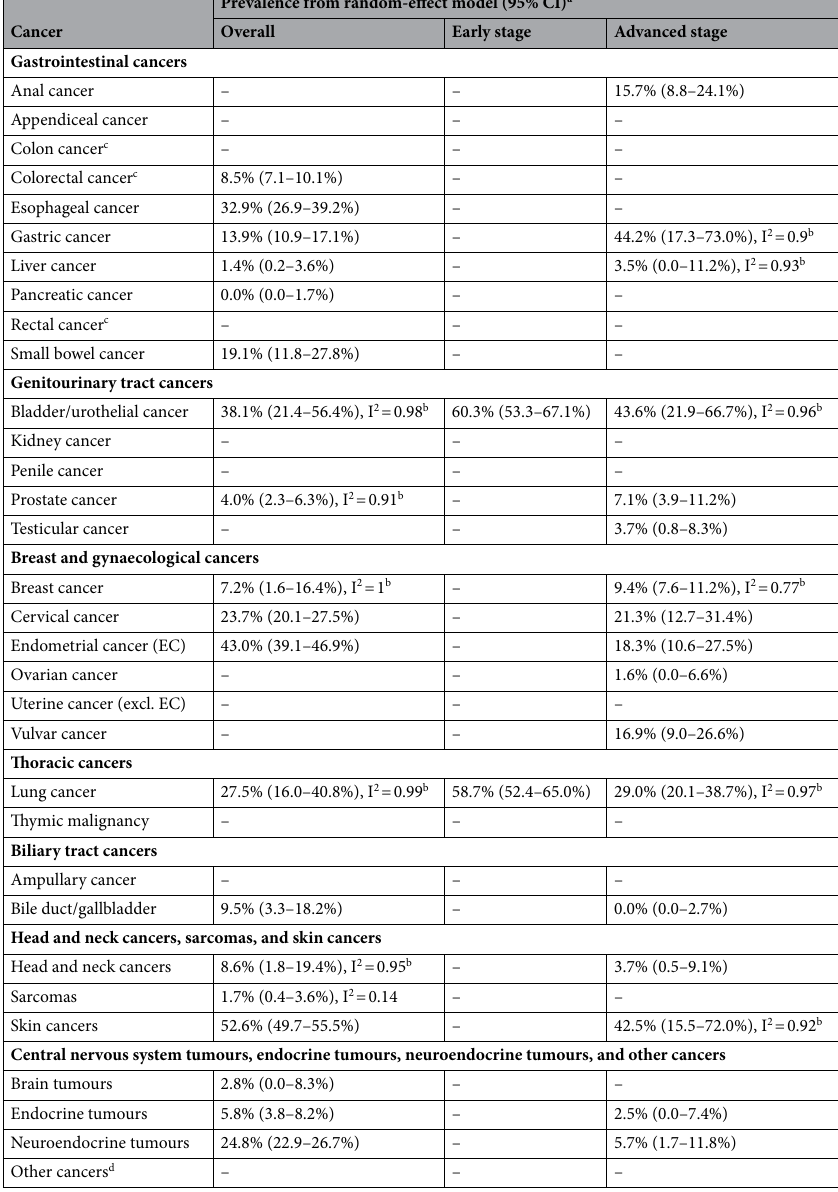
Table 4. Prevalence of high tumour mutational burden (≥ 10 mutations/Mb) in adult solid tumours by cancer type and stage. a Heterogeneity across studies was presented based on the point estimate of I 2 score and heterogeneity test, if ≥ 2 records were available for each cancer type and stage group. b Statistically significant heterogeneity across studies (p < 0.05). c We analysed the pooled prevalence of pan-tumour biomarkers separately based on estimates including (1) colon cancer only, (2) rectal cancer only, and (3) tumours at any sites in the colon and the rectum, obtaining pooled prevalence estimates described as “colon cancer”, “rectal cancer”, and “colorectal cancer”, respectively. d Other caners include cancer of unknown primary, cancer of unknown primary-neuro, germ cell tumour, peritoneal cancer, and underspecified cancer. See Supplementary Tables S7 and S12 for the number of records included in the analysis and the